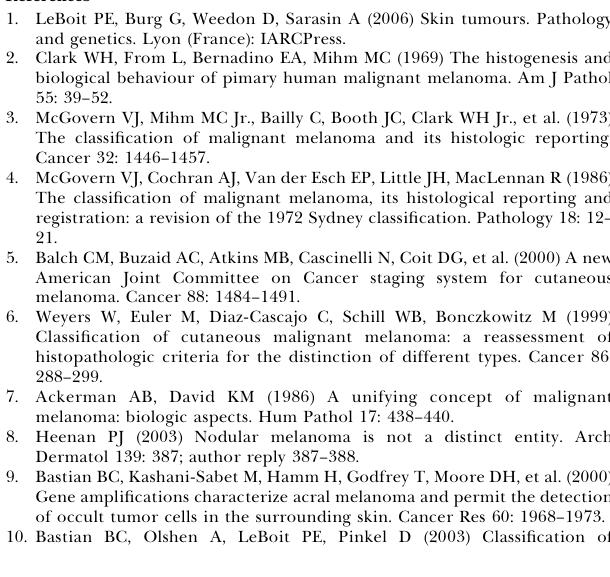
Table S7. Comparison of Features within SSMs by Mutation Status of BRAF and NRAS Total percentages that do not add up to 100% have missing values. Table S8. First Metastasis Site Site of first metastasis in patients who are older and younger than 55 y of age recorded in the Southern German Tumor Registry, with Chi- squared p -value analysis showing a significant ( , 0.0001)